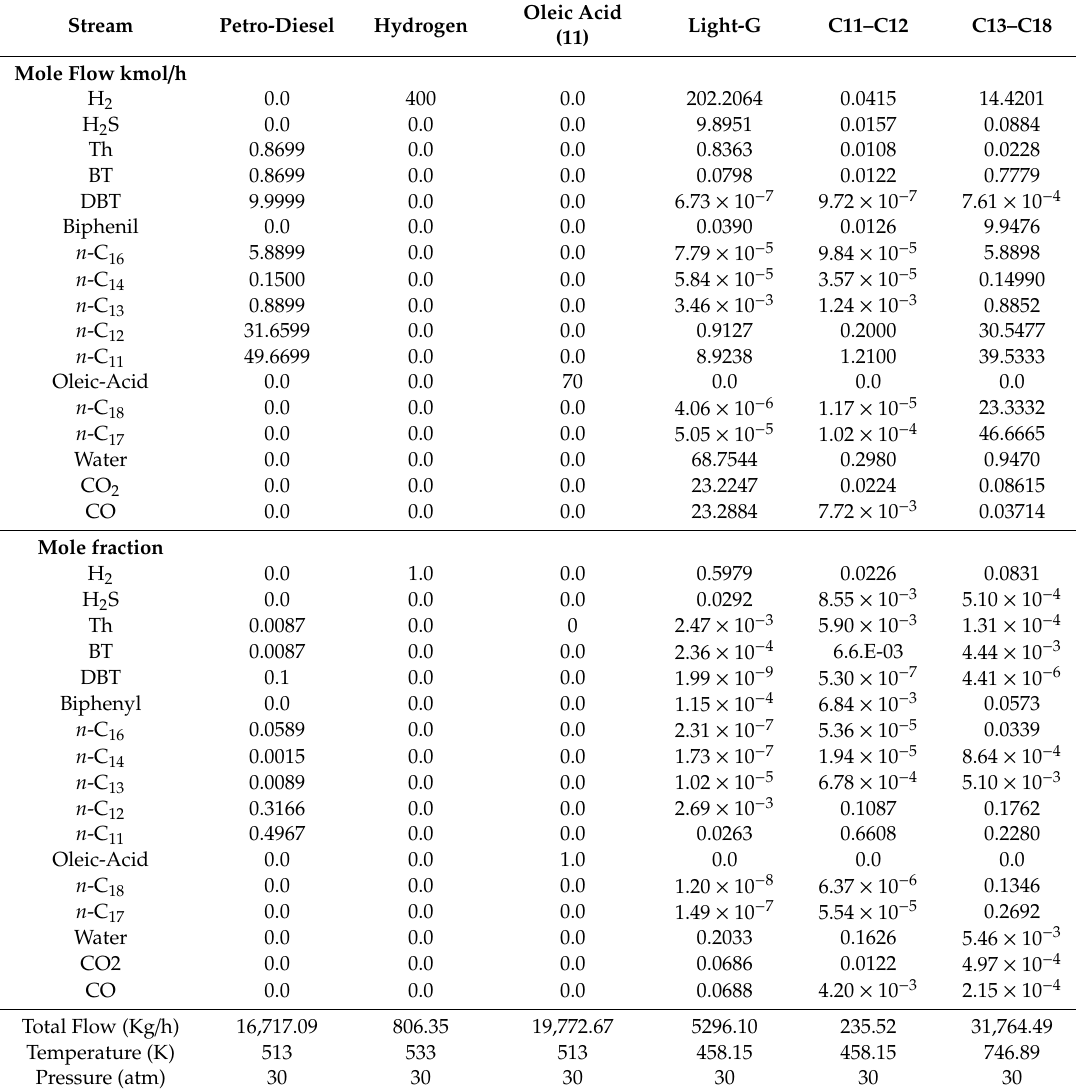
Table 3. Simulation results of the HDS-HDO section in ASPEN-PLUS (reference